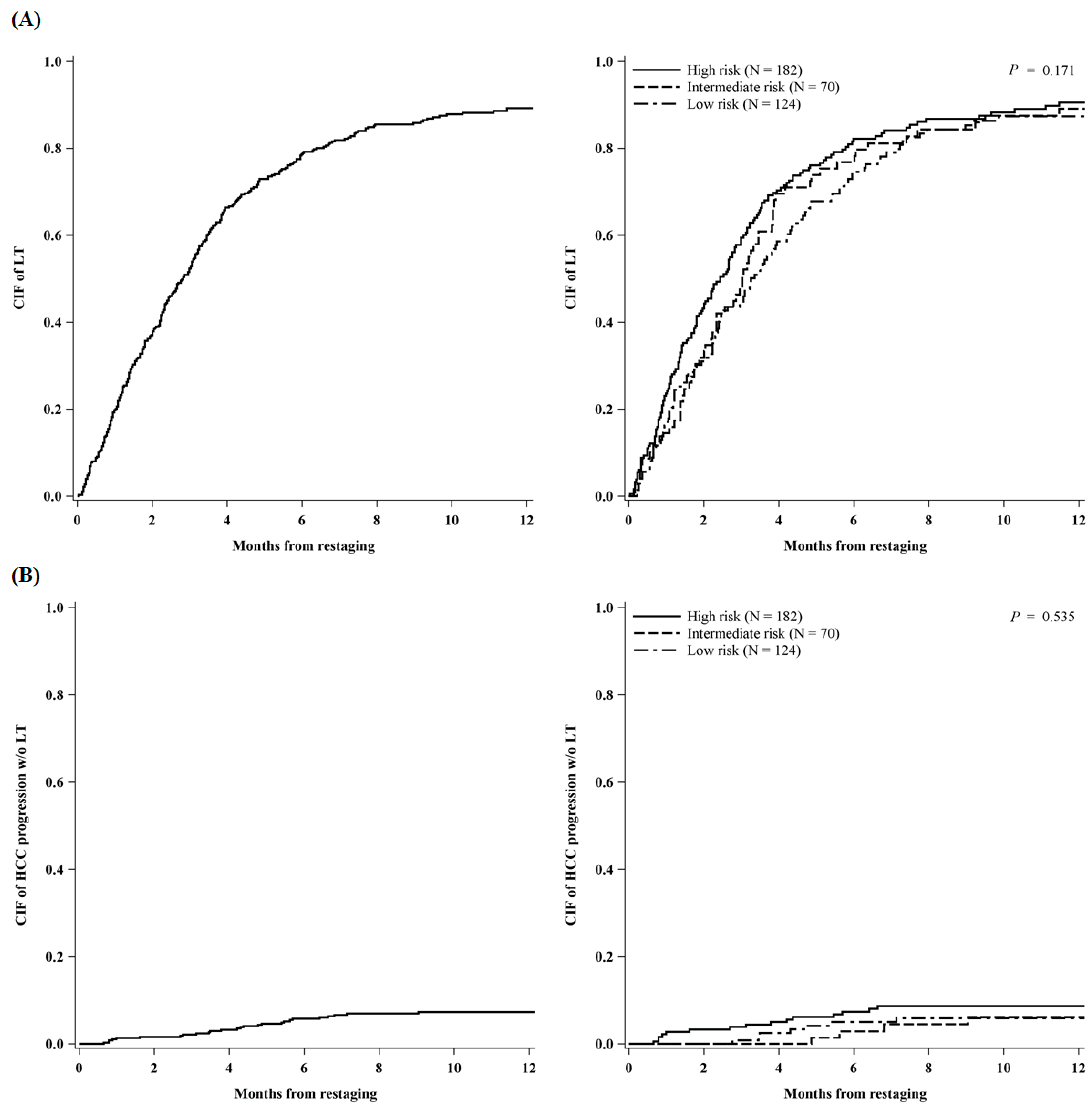
Figure 4. Cumulative incidence of liver transplantation ( A ) and HCC progression w/o liver transplantation ( B ) calculated from restaging, overall and by priority (N =